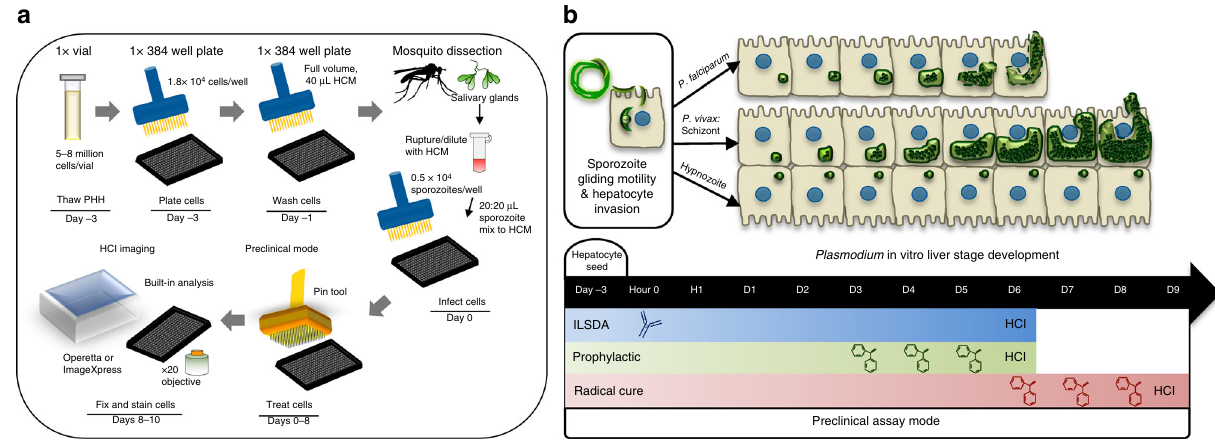
Fig. 1 Experimental work fl ow for multispecies drug and vaccine preclinical assays. a A single vial of a pre-established cryopreserved primary human hepatocyte (PHH) donor is suf fi cient to seed a full 384-well plate and run 360 single-point therapeutic candidates. By day 3 post-seed, PHHs show in vivo- like phenotypes and are suitable for Plasmodium sporozoite infection. De fi ned preclinical assay modes are standardized using semi-automated hand pipettes and a 384-well pin tool. Upon experiment fi xation, plates are fl uorescently stain with a speci fi c LS biomarker and imaged on a high content imaging (HCI) system. b Plasmodium sporozoites exhibit gliding motility while traveling from the injection site in the dermis to liver. Contact with liver components, including Kupffer cells, highly sulfated heparan sulfate proteoglycans, and liver endothelium triggers proteolytic processing of surface proteins (i.e., circumsporozoite protein) and activation of hepatocyte invasion machinery (i.e., TRAP, TREP, P36). Antibody inhibition of invasion pathways can be assessed by pre-incubation of infectious sporozoites with test serum or puri fi ed antibody in vitro prior to infection of plated hepatocytes (ILSDA). Following successful invasion, including formation of a parasitophorous vacuole membrane, P . vivax differentiates into hypnozoites and liver schizonts, which complete development after day 9. Day 5 or 6 is an ideal endpoint for both P . falciparum and P . vivax , for ILSDA and prophylactic drug response assays, as P . falciparum completes development shortly thereafter, and P . vivax schizonts are then distinguishable from hypnozoites based on size and morphology. Radical cure drug response assays are ended at day 8 to allow for treatment and clearance of susceptible liver